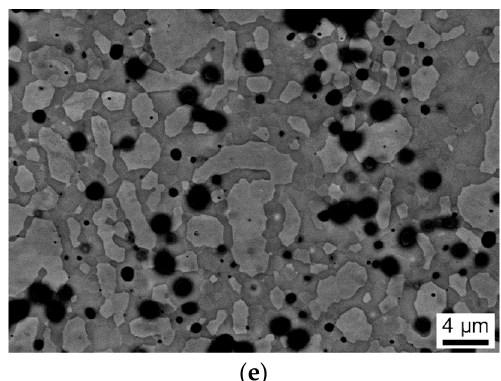
Figure 2. SEM micrograph and element composition of the unprocessed sample. ( a ) microstructure; ( b ) spectrum 1; ( c ) spectrum 2; ( d ) spectrum 3; ( e ) substrate.